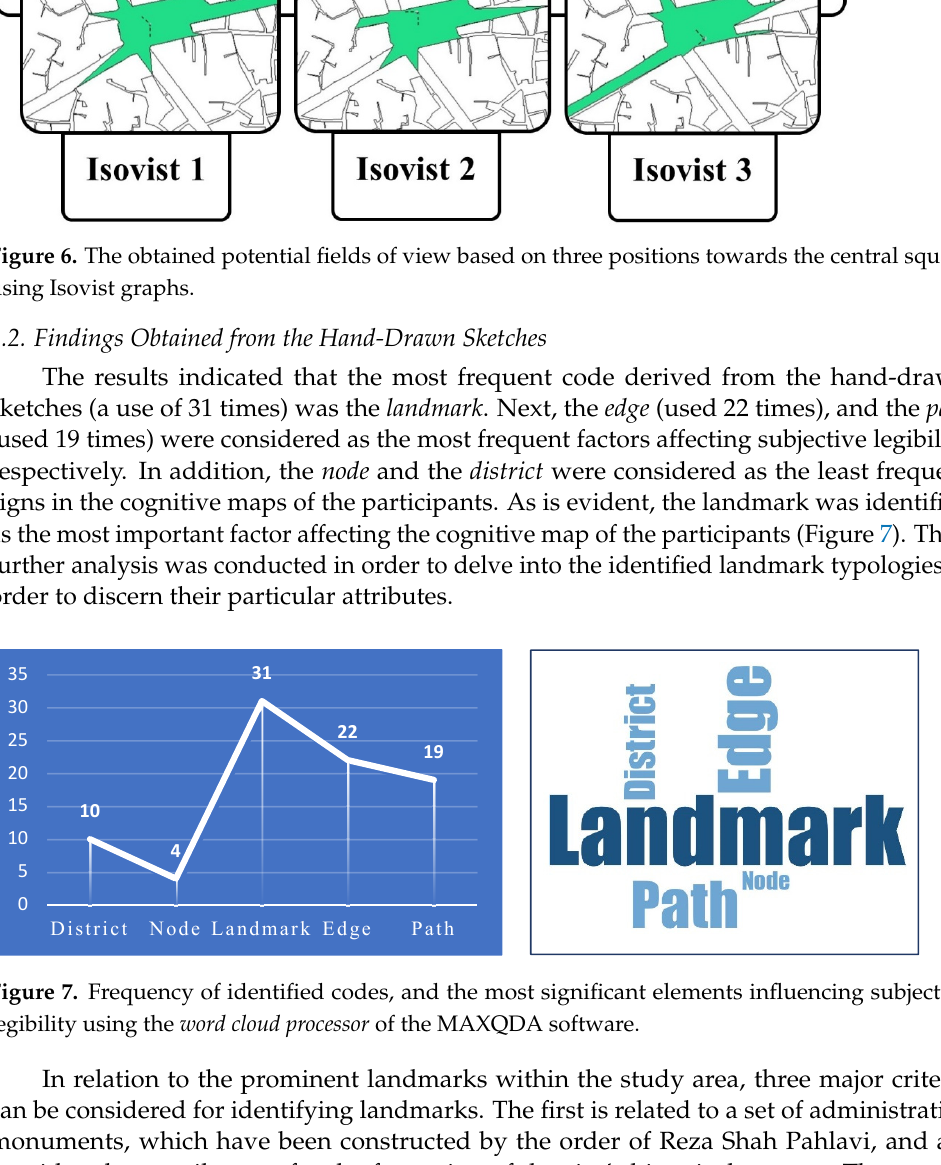
9 of 19 Figure 5. The spatial intelligibility values in different cases using the Space Syntax method, per- formed by the Depthmap software. According to the conducted analysis, it was intended to further investigate the cen- tral square in terms of its visual capabilities using Isovist graphs in order to understand which positions provide a better field of view. Since the notion of spatial legibility is strongly associated with the characteristics of seeing and being seen [27], Isovist graphs may offer the most potential field of view within the main milieu, which can lead to the